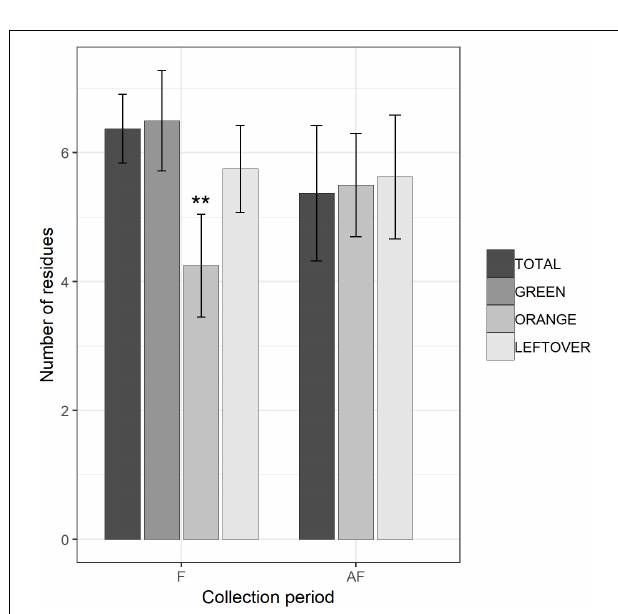
FIGURE 3 | Number of fungicide residues detected in each sample, during (F) and 2 weeks after the end of apple blossom (AF). Asterisks show statistical significance ( ∗∗ p < 0.01). Error bars report standard error of the mean. Pollen color groups are reported in scale of